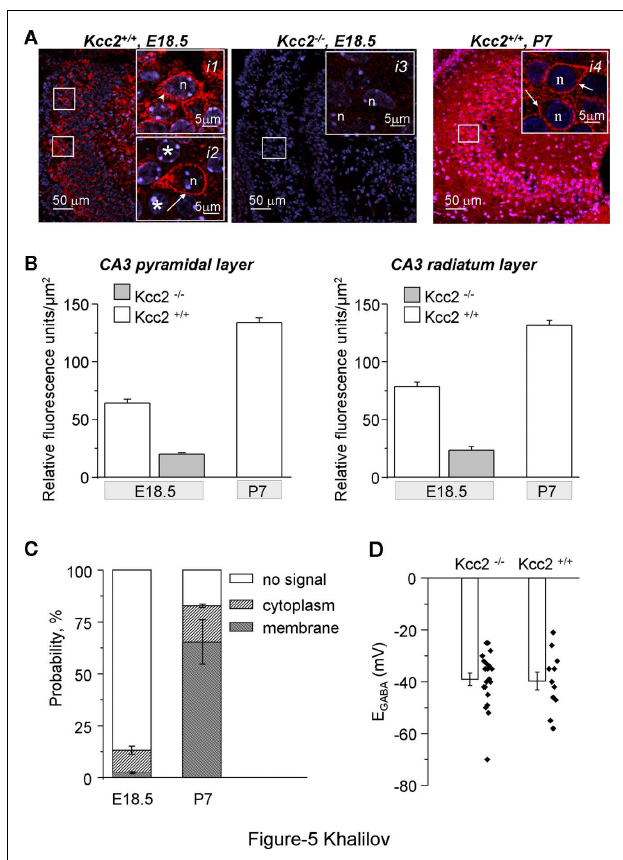
FIGURE 5 | Expression of the KCC2 in CA3 hippocampal neurons. (A) Immunoreactivity of KCC2 (red) in CA3 pyramidal neurons of Kcc2 + / + and Kcc2 − / − mouse as indicated. Notice the absence of the KCC2-positive immunoreactivity in Kcc2 − / − samples characterizing high specificity of the antibody.The arrowhead in insert i1 illustrates typical KCC2-positive CA3 neuron in E18.5 Kcc2 + / + hippocampi with immunoreactivity localized in cytoplasm. Asterisks in insert i2 indicate KCC2-negative neurons, whereas arrow indicates a rare neuron with KCC2 immunoreactivity localized in membrane region. For comparison, insert i4 illustrates a typical KCC2 immunoreactivity distribution in CA3 neurons of P7 Kcc2 + / + mouse that is localized in most of neurons in membrane region (shown by arrows). n = nucleus. (B) Quantification of the KCC2 immunoreactivity in CA3 pyramidal and radiatum layers of Kcc2 − / − (E18.5) and Kcc2 + / + (E18.5 and P7) hippocampi. Mean ± SEM, n = 3.The difference between any two values in both plots is highly significant ( P < 0.01, t -test). (C) Age-dependent distribution of neurons’ populations expressing KCC2 in membrane region (“membrane”), in the cytoplasm only (“cytoplasm”), and without detectable KCC2 immunoreactivity (“no signal”). Normalized values obtained after analysis of 50–100 neurons per animal, n = 3 Kcc2 + / + mice per age.The background (no signal) level of fluorescence was determined after analysis of the immunofluorescence of sections prepared from E18.5 Kcc2 − / − mice ( n = 3; see Materials and Methods for details on fluorescence analysis). (D) Reversal potential of isoguvacine-induced responses in CA3 hippocampal neurons measured using gramicidin-perforated patch-clamp recording. Mean ± SEM, n = 6 mice per condition, two to four neurons per mouse. Dots show values in individual measurements.There was no difference in mean values of E GABA .